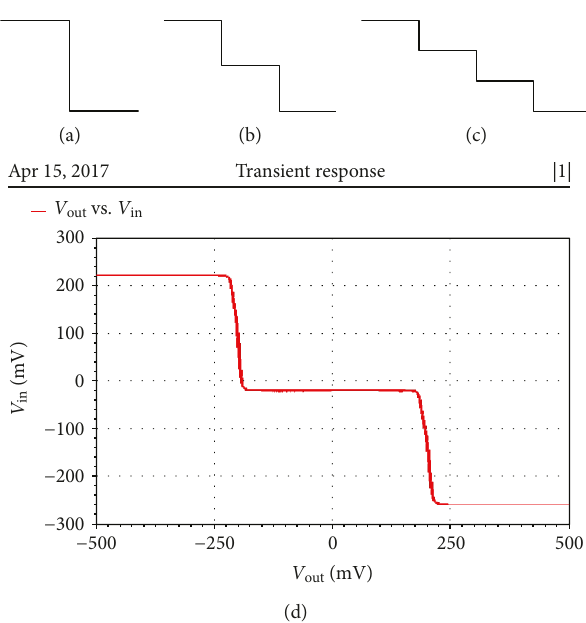
Figure 9: The staircase function: (a) N = 1 , (b) N = 2 , and (c) N = 3 . (d) Simulated staircase function circuit with N = 2 .